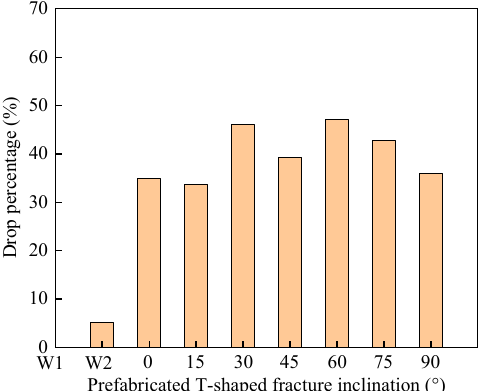
( b ) Figure 6. Relationship between fracture inclination and di ff erent thresholds, stress ratios of intact and T-shaped fracture samples: ( a ) Relationship between di ff erent thresholds and fracture inclina- tion; ( b ) Relationship between stress ratio and fracture inclination. As shown in Figure 7, the peak strength of the intact specimen without water pres- sure is larger than the intact specimen with water pressure, which is greater than all